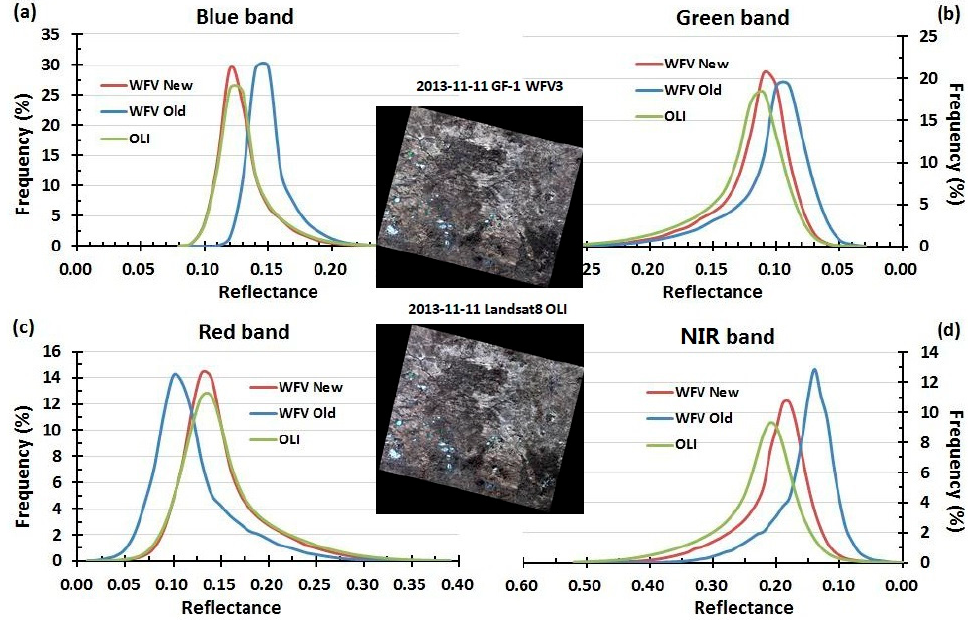
Figure 10. Comparison of the reflectance histograms in one WFV–OLI image pair for four bands: ( a ) Blue band; ( b ) Green band; ( c ) Red band; and ( d ) NIR band. Both cross calibrated (new) and officially calibrated (old) WFV reflectance were included.